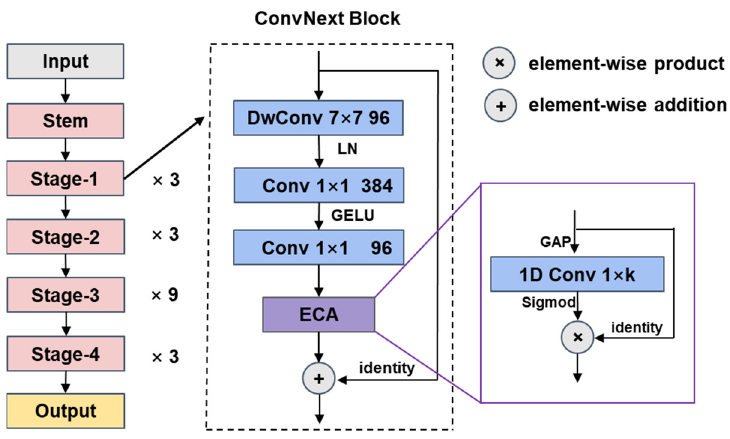
Figure 4. The structure of ConvNext-E.